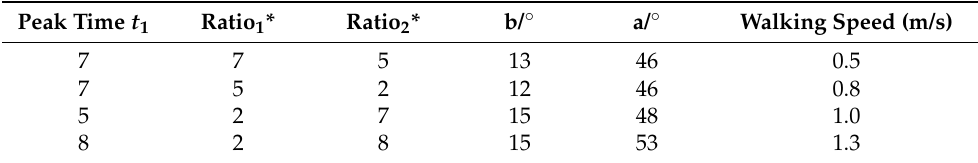
Figure 8. Joints kinematics of the simulated bipedal robot. Table 3. Optimized variables of the torque curve for the ankle joint at different walking